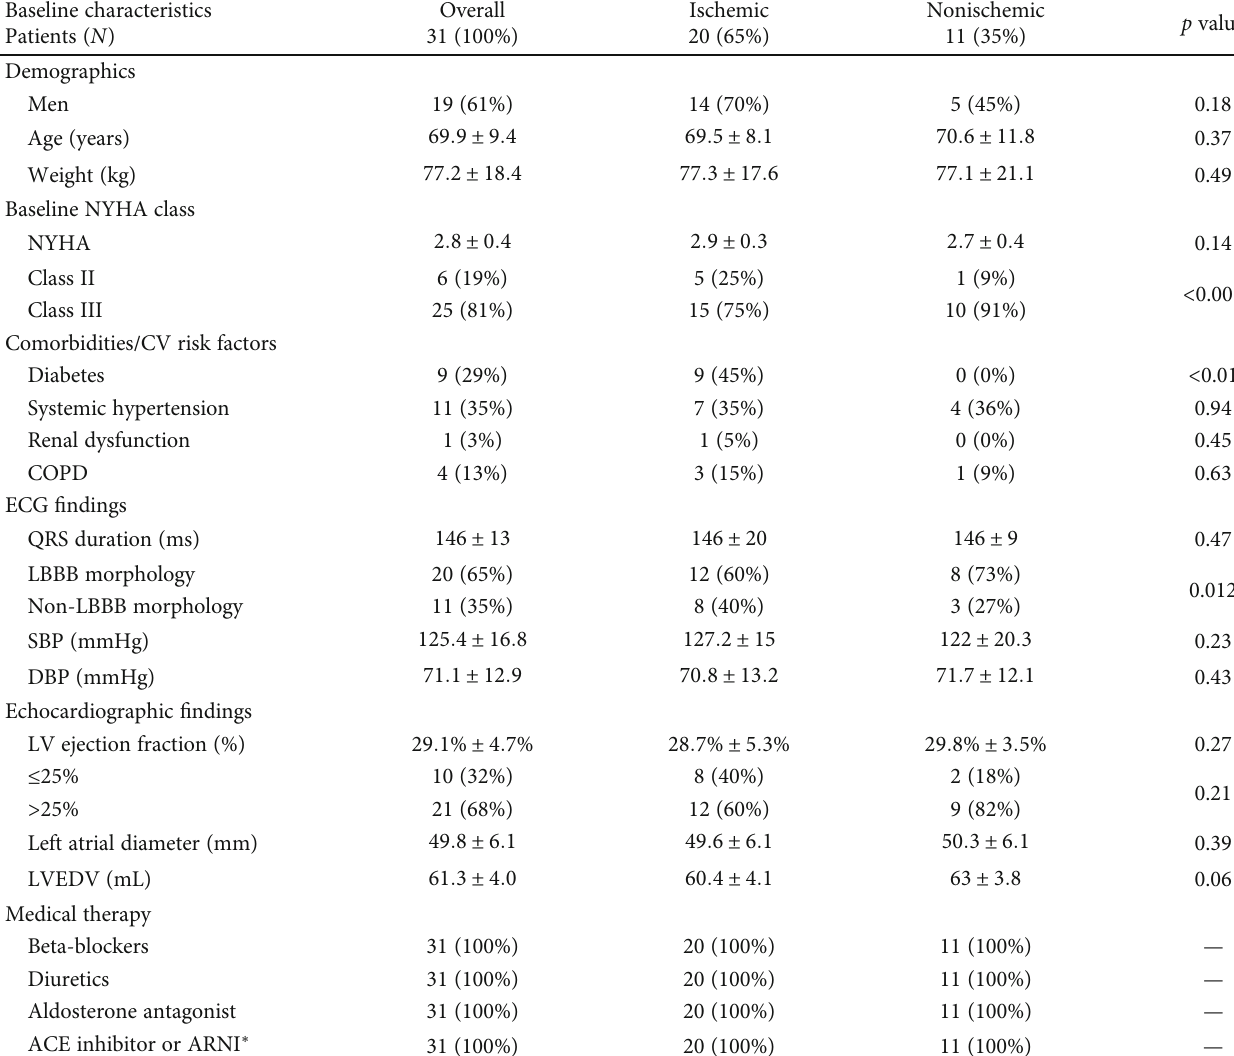
Table 1: Baseline characteristics of heart failure patients, overall and by etiology (ischemic versus nonischemic). Baseline